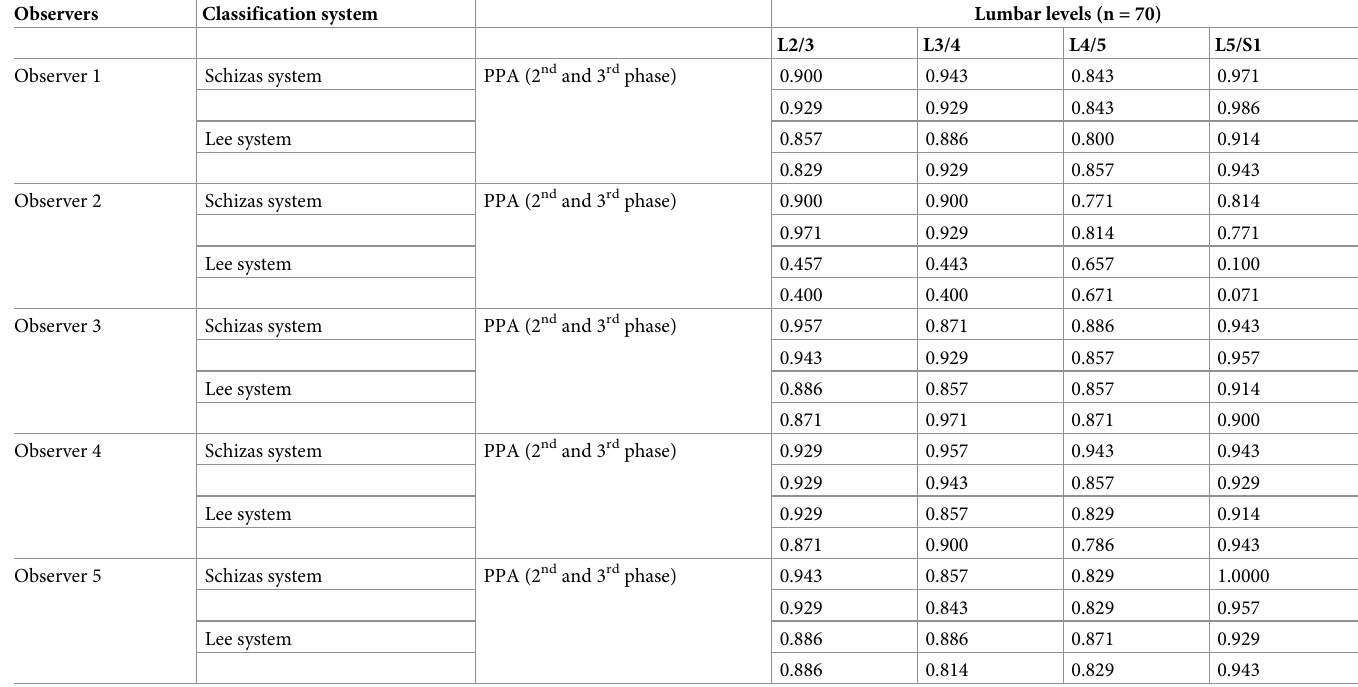
Table 5. Positive percentage agreements of the Schizas and Lee